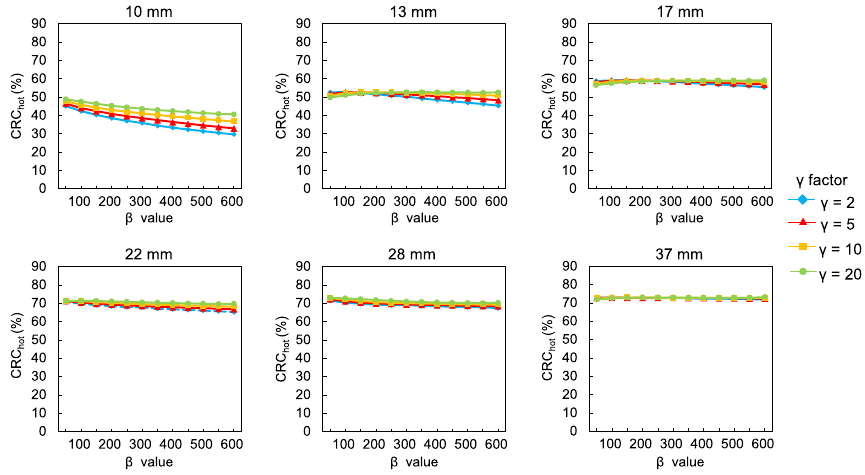
Fig. 1 Percent hot contrast recovery coefficient (CRC hot ) of hot spheres as function of β 50–600 for each γ